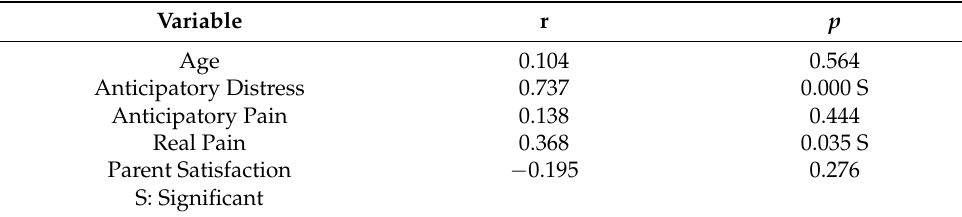
Table 2. Spearman’s correlation coefficient. Real distress.